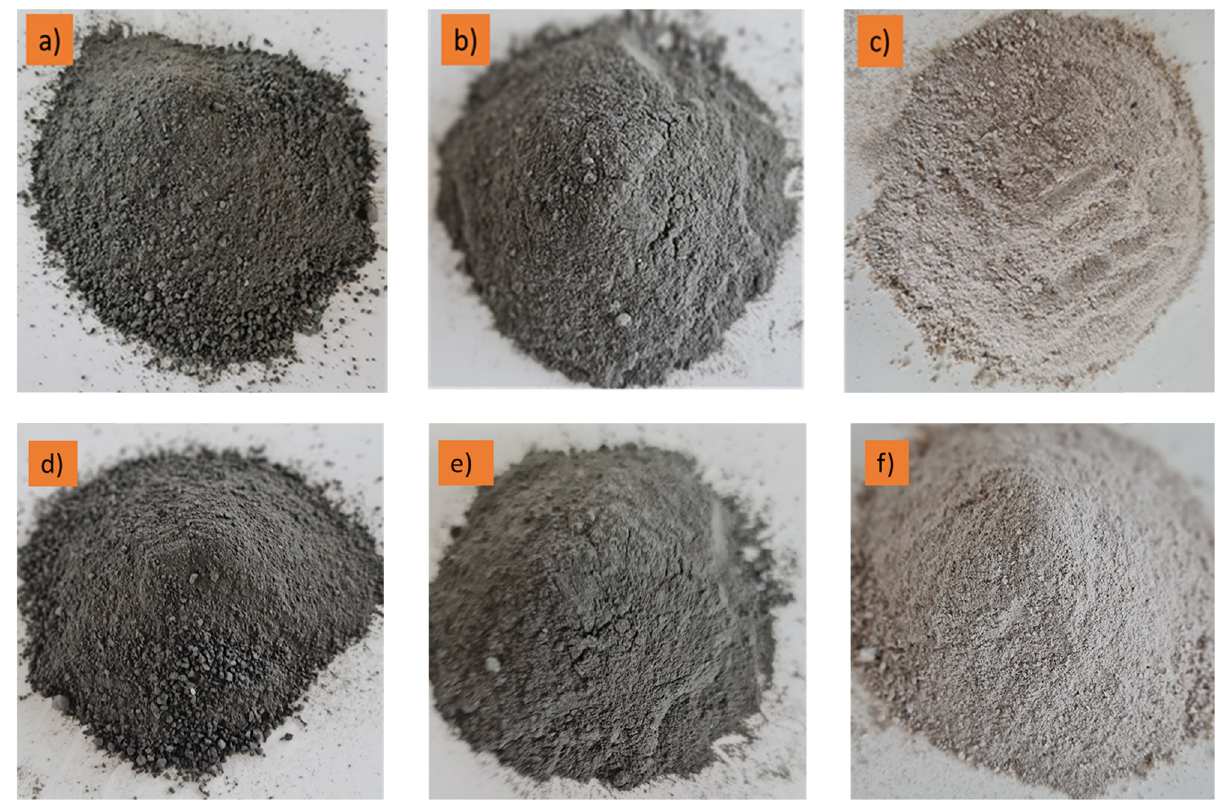
Figure 4: Roller press output products clinker ( a ) , GVT ( b ) , BVT ( c ) , hammer output products clinker ( d ) , GVT ( e ) , and BVT ( f )